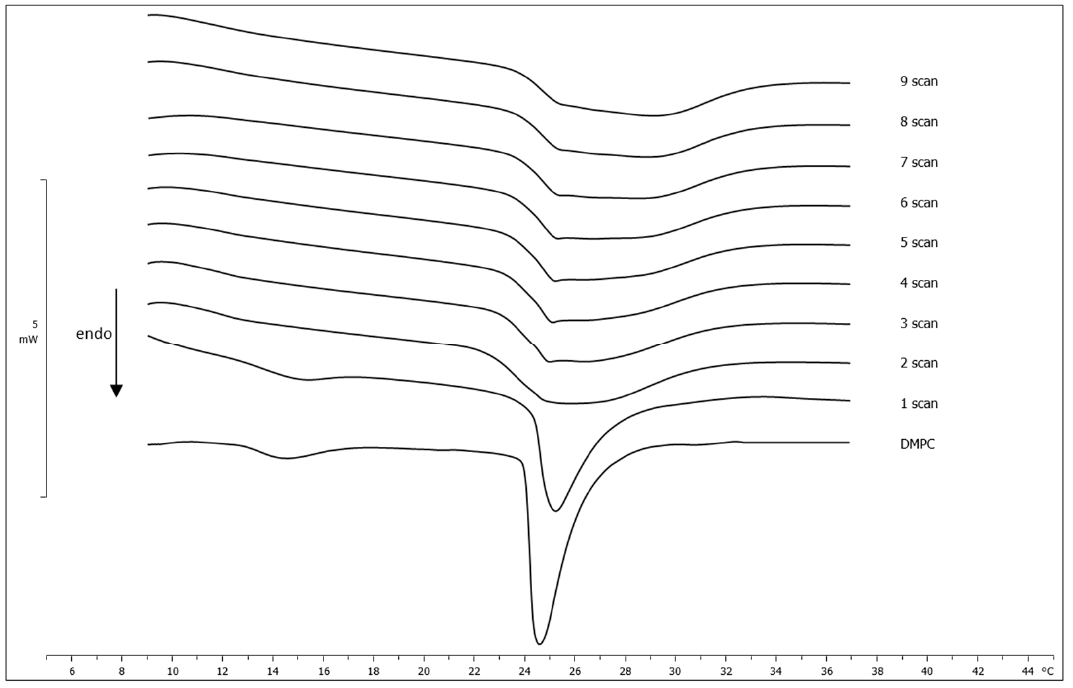
Figure 2. Calorimetric curves, in heating mode, of DMPC MLVs left in contact with RH-23 at a molar fraction of 0.12 at different incubation times.